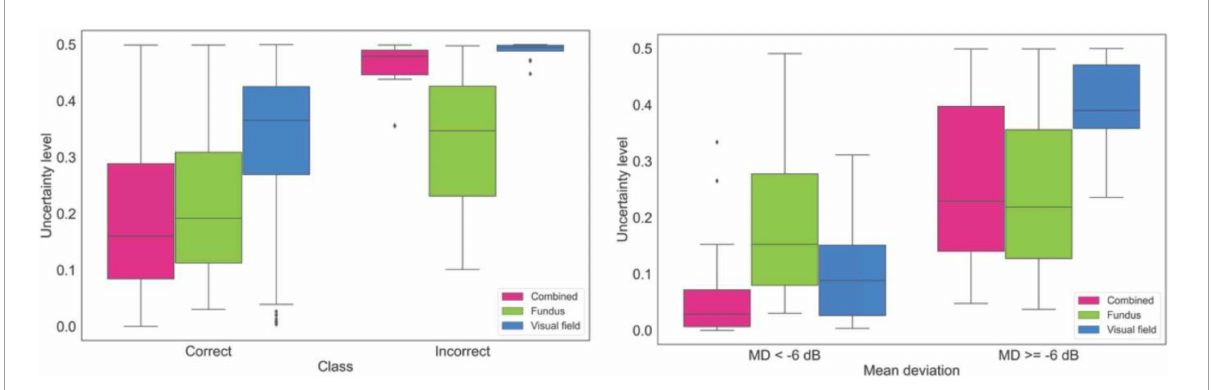
FIGURE5 Uncertainty of the model in making diagnosis based on data from the independent validation dataset. Left: Uncertainty level of AI for making correct and incorrect diagnosis based on fundus photographs, visual fields, and combined modality. Right: Uncertainty level of AI in making diagnosis on fundus photographs, visual fields, and combined modality based on glaucoma severity